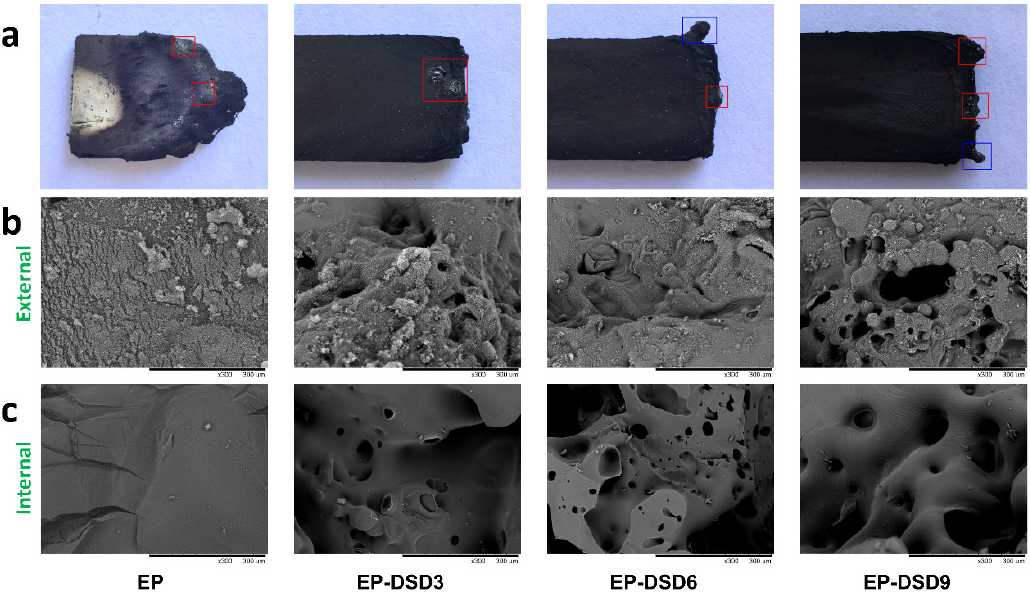
Figure 4. Digital photos and SEM photographs of neat EP and EP–DSD thermoset char residues after the UL-94 test. ( a ) Digital photos of char residues after UL-94 test, ( b ) SEM photographs of external char residues marked with red box, ( c ) SEM photographs of internal char residues marked with red box. Red box: Char residues was observed by SEM. Blue box: Raised stomates which found on char residues.